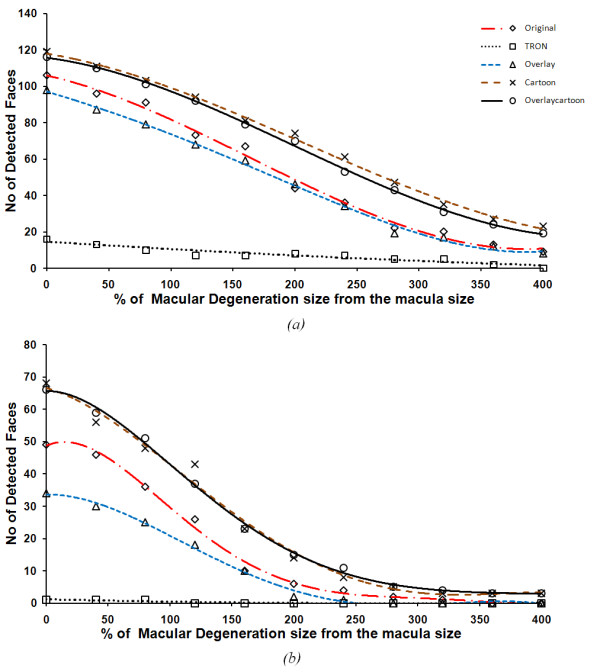
The performance of face detection when image enhancement algorithms are used. The number of detected faces over all the 14 images with different levels of macular degeneration for the original and the four image enhancement algorithms using the Viola-Jones face detection method (a) and Kienzle method (b).